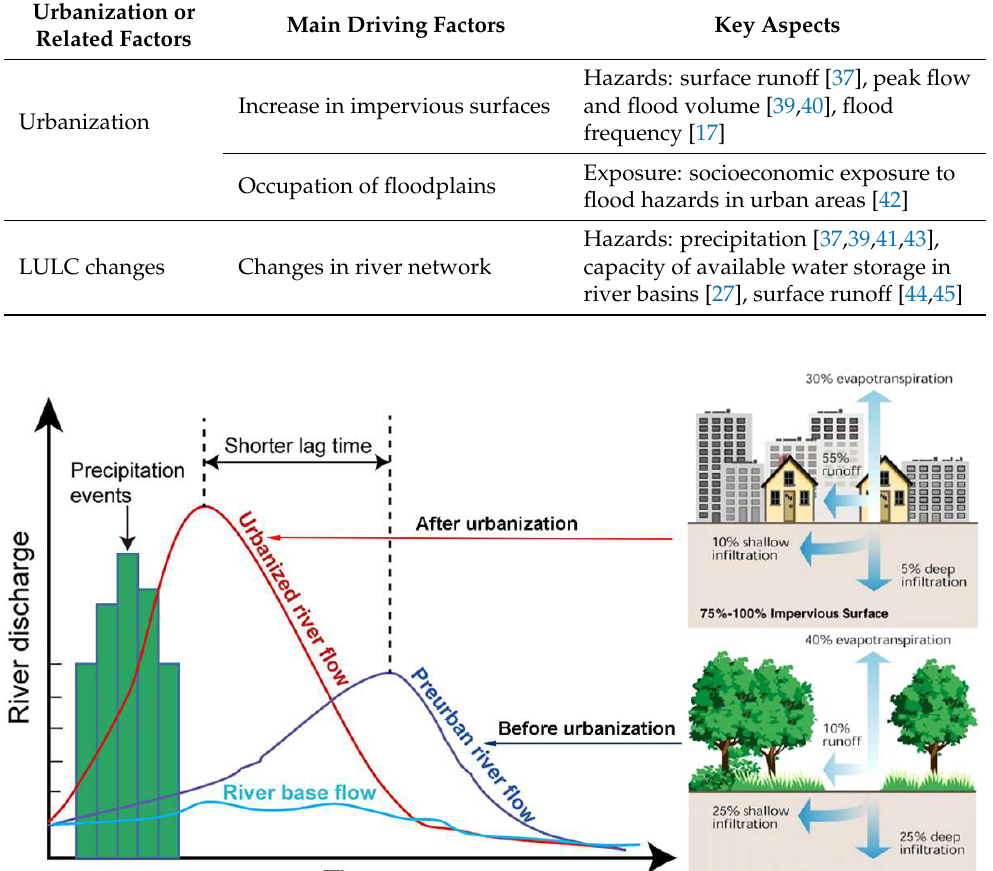
Table 1. Main driving factors and key aspects of flood risk affected by urbanization.